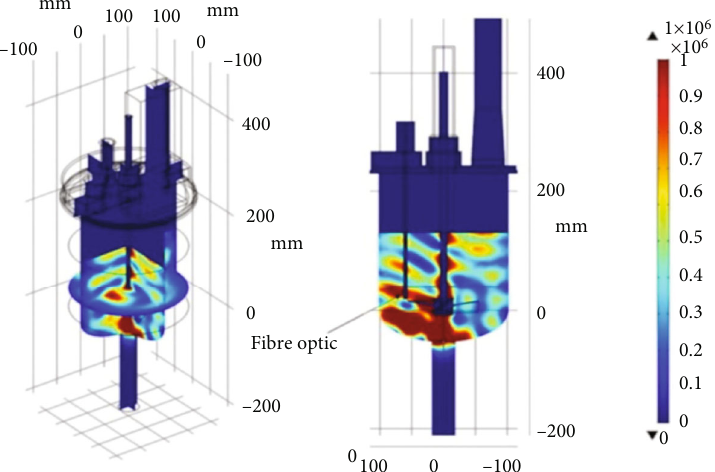
Figure 17: Simulation of electromagnetic fi eld power density in the reaction volume (a) and in a section of the reaction volume (b) (reprinted from Buttress et al. [95] with permission. Copyright © 2019 Elsevier Ltd.).